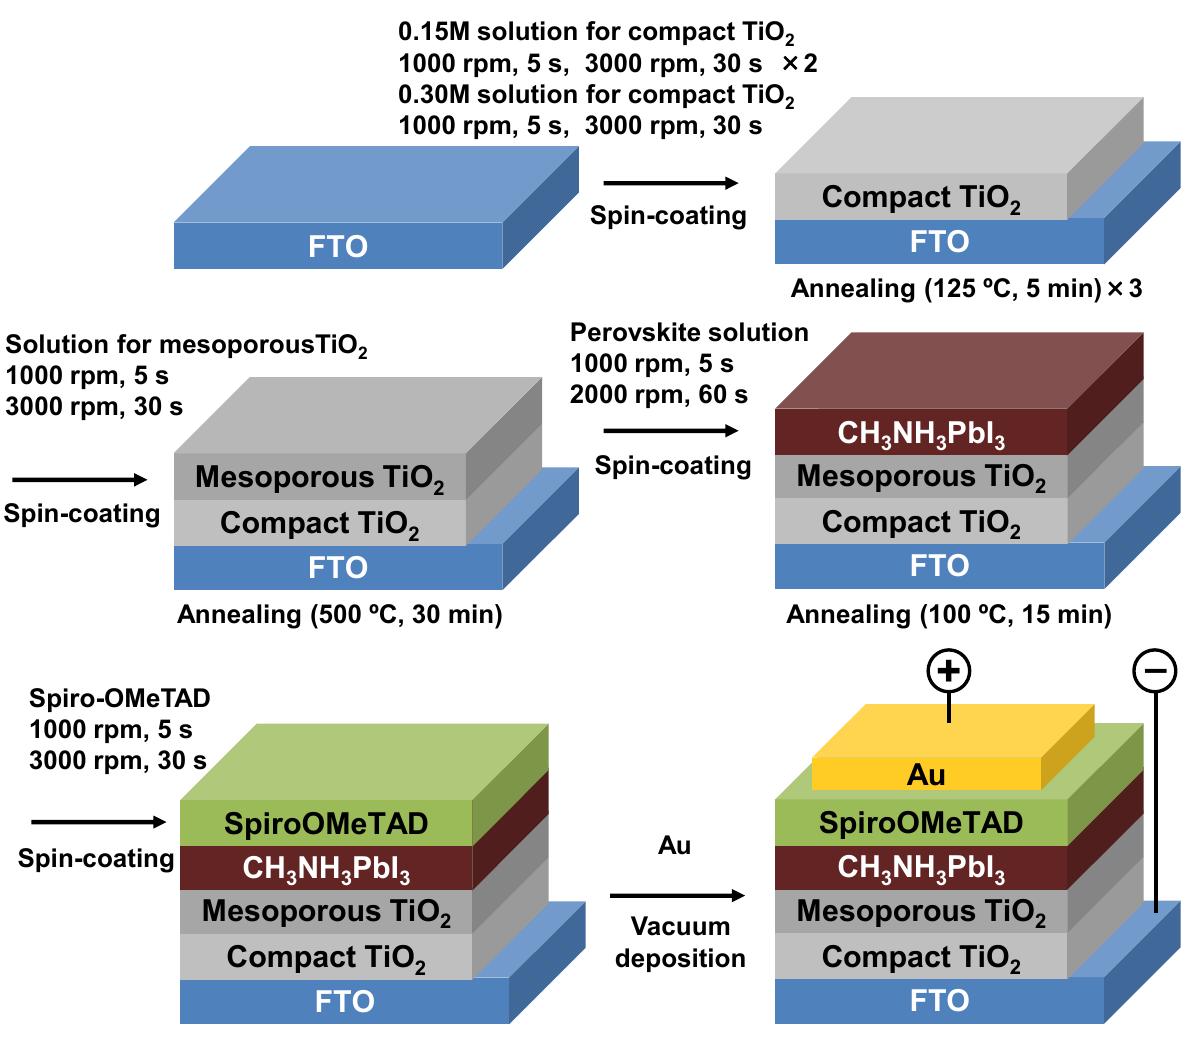
Figure 1. Schematic illustration of the fabrication of photovoltaic cells using CH 3 NH 3 PbI 3 and TiO 2